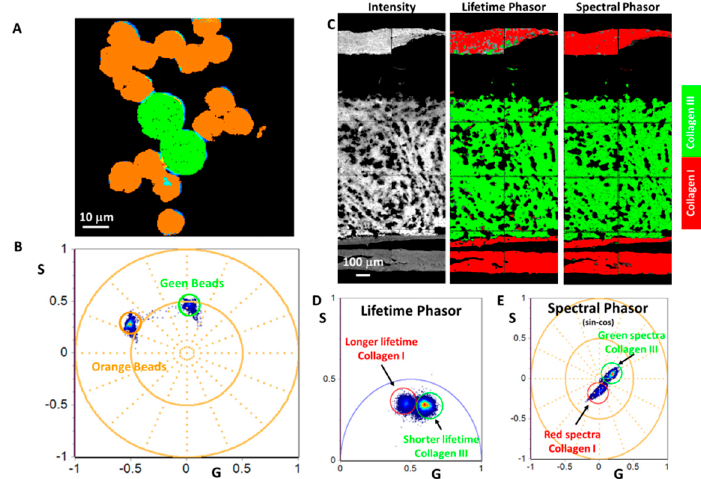
Figure 9. Application of hyperspectral imaging using the sin-cos filters and the spectral phasor transformation. ( A ) 15 µ m Yellow-Green and 10 µ m Orange fluorescent beads in a highly scattering matrix. ( B ) Spectral phasor plot of beads in (A): using orange and green cursors it is possible to separate di ff erent types of beads. ( C ) Images of mouse femur bone. ( D ) FLIM phasor. ( E ) Spectral phasor acquired with sin-cos filters. Both FLIM and spectral phasors allow identifying areas with di ff erent kind of collagens (I and III).